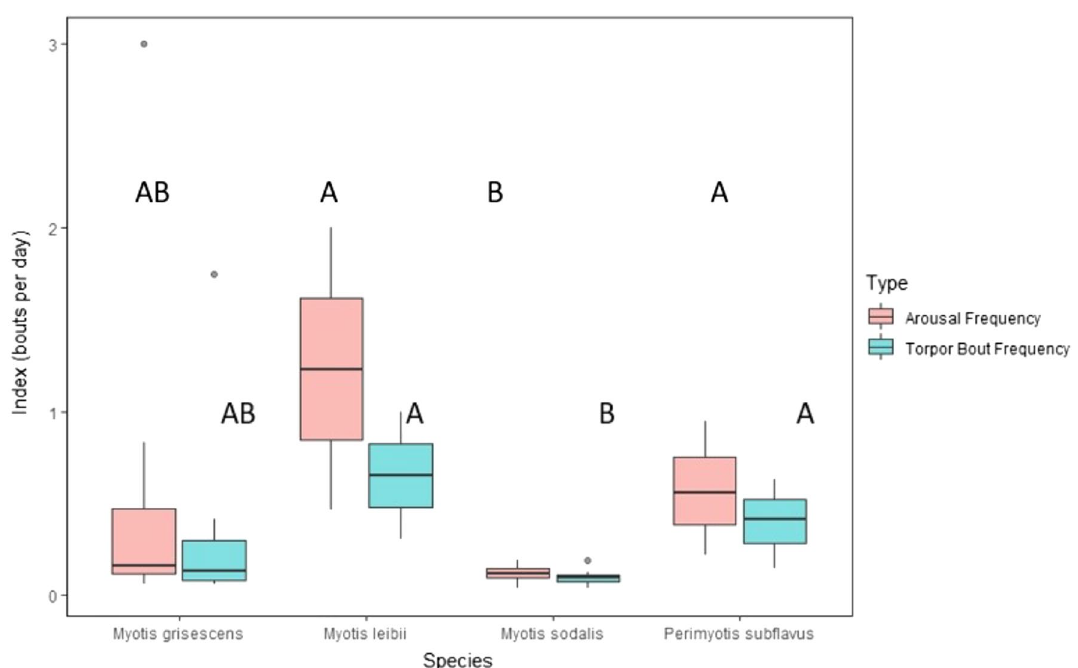
Figure 4. Torpor bout and arousal bout frequency indices (bouts/day) of four target bat species tracked with temperature-sensitive radio transmitters at four cave hibernacula in Tennessee during hibernation (November 1–March 31) of 2016–2019. Dots above plots represent outlying data. *Boxplot data followed by the same uppercase letter not significantly different ( P >